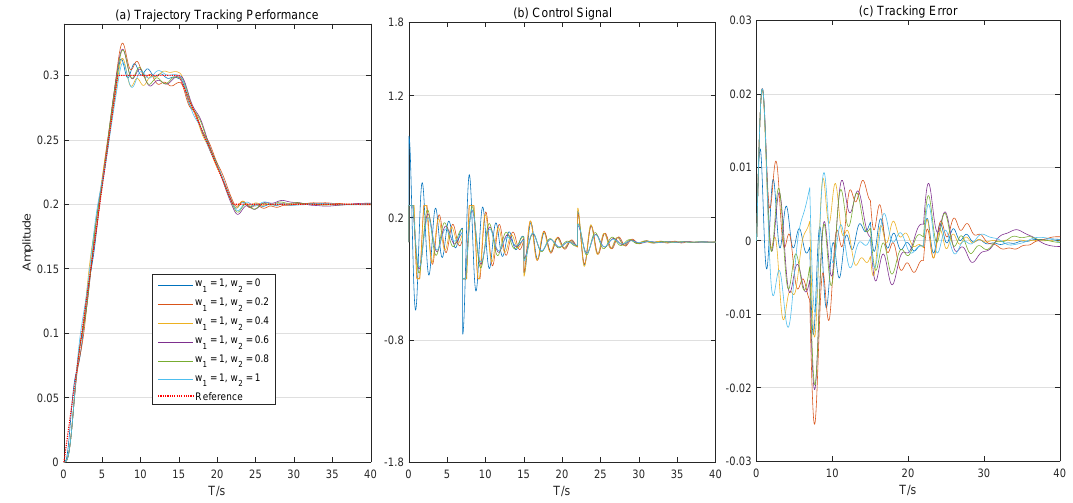
Figure 6. Trajectory tracking performance of AUV depth